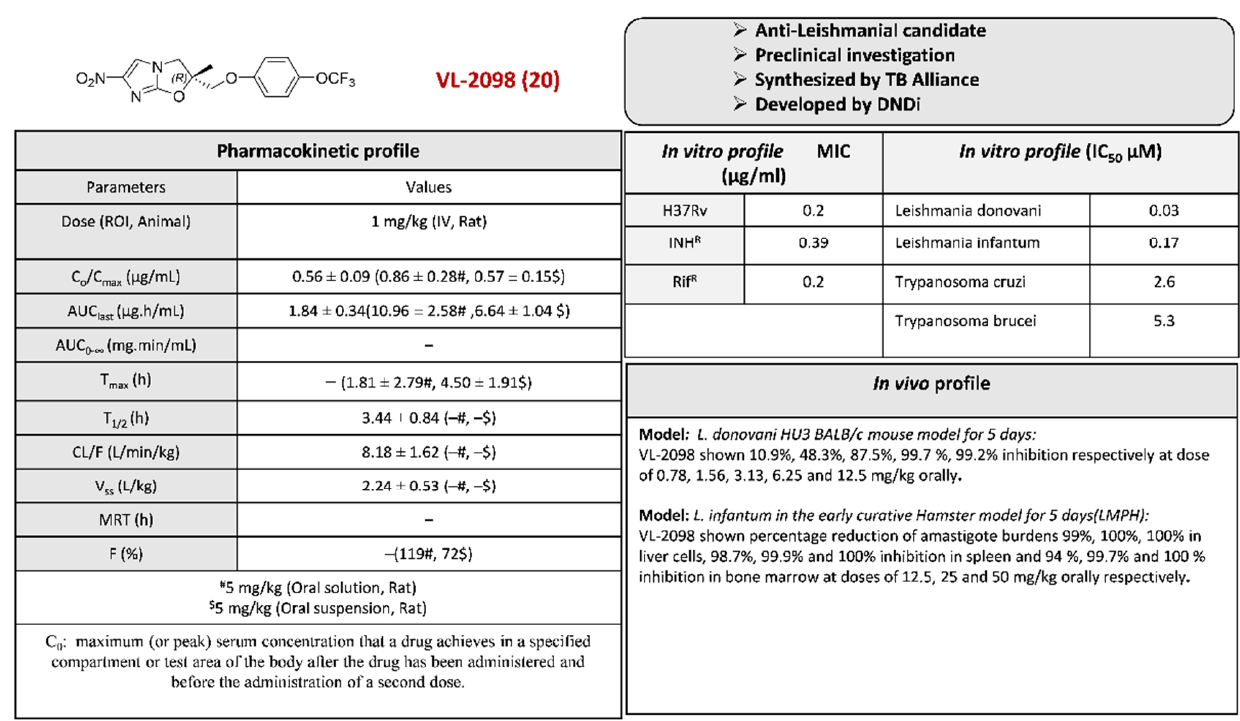
Figure 24. Activity profile of VL-2098 20 [186,187].